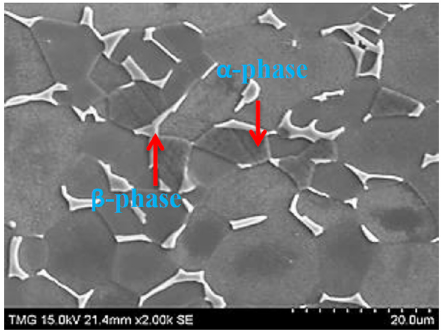
Figure 1. Scanning electron microscope (SEM) micrographs showing the initial Ti ‐ 6Al ‐ 4V microstructure.